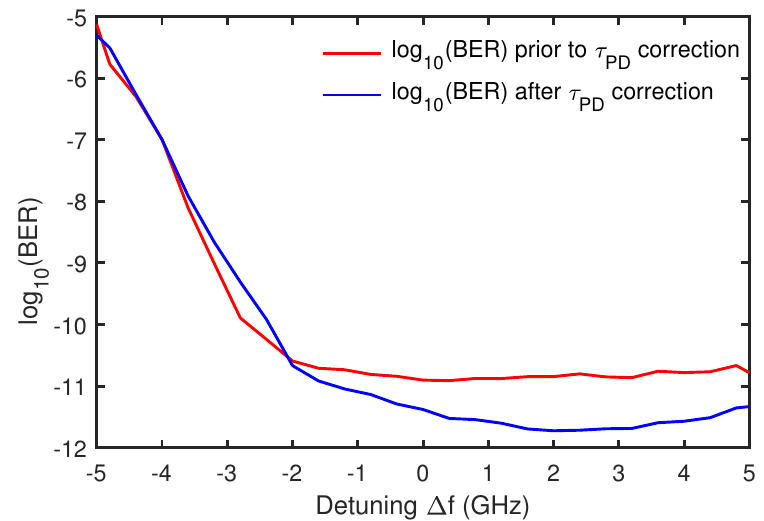
Figure 11. Estimation of BER values of the recovered messages as a function of frequency detuning for BR = 1.2 Gbit/s, b = 0.2, and η = 15 ns − 1 . Red (blue) trace correspond to BER value prior to (after) the τ PD correction in the receiver laser.